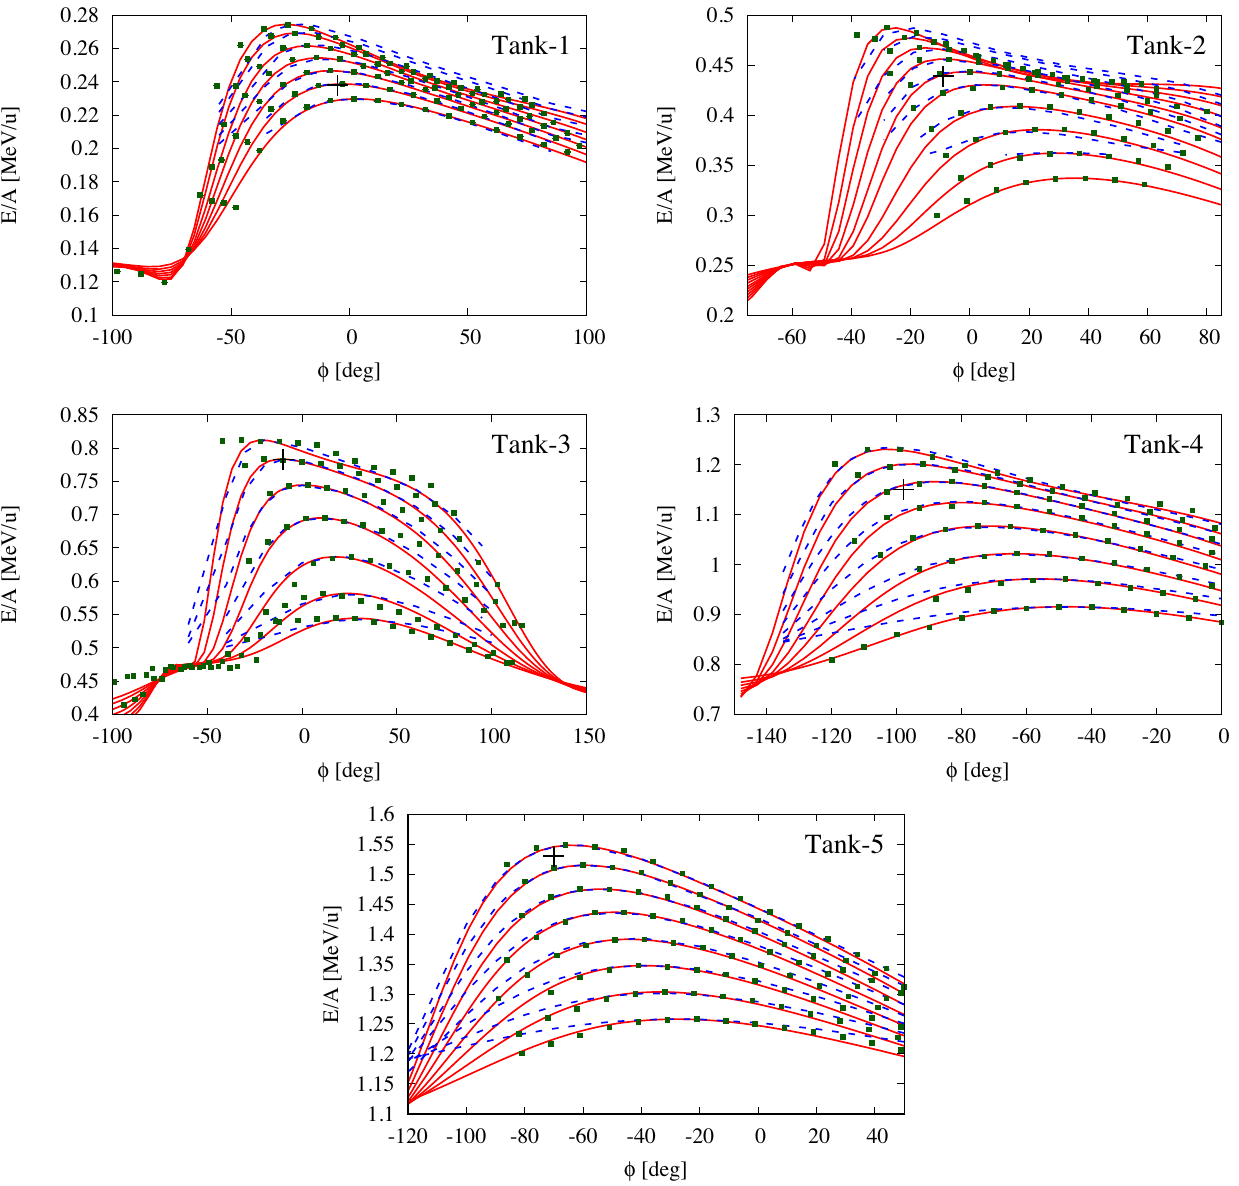
FIG. 8. TRANSOPTR (red) and LORASR (blue) simulations of ISAC-DTL IH-Tank output E=A at variable rf phase but fixed on axis electric field scaling V 0 . ISAC-DTL measured 16 O 4 þ E=A response superimposed in green. The LORASR model assumes perfect field flatness, while the TRANSOPTR model features a sagging in the maximum peak amplitude (Fig. 3). The setpoint of each tank at maximum operational acceleration (Table I) is shown as a black cross on each figure. Note the x axis phases are absolute, meaning optimum acceleration is not necessarily at